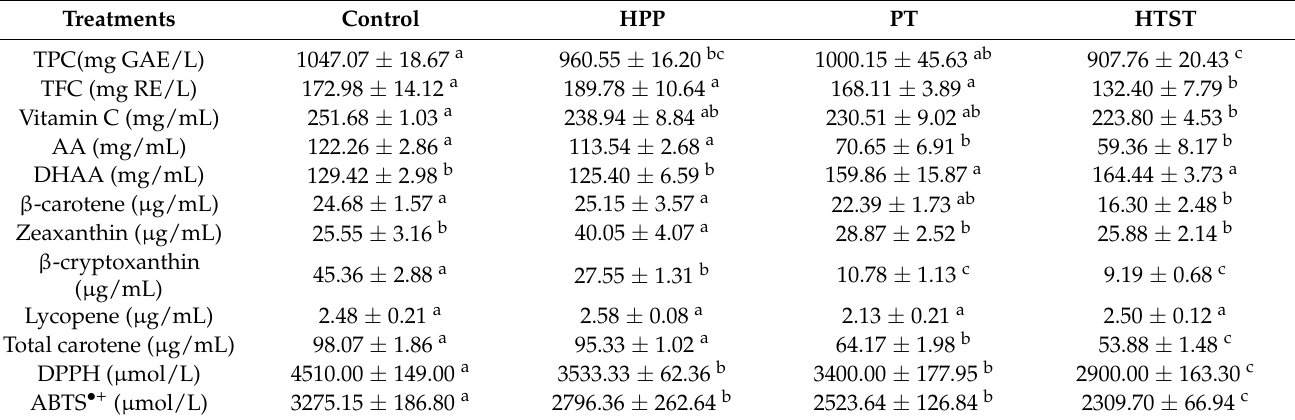
Table 4. Effect of high-pressure processing (HPP), pasteurization (PT), and high-temperature short time (HTST) on antioxidants (TPC, TFC, Vitamin C, carotenoids, and TAC) of passion fruit pur é